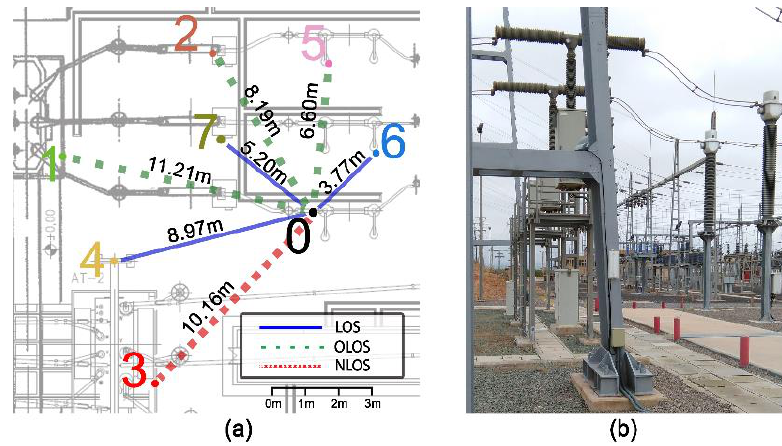
Figure 2. ( a ) Simulated base network ( b ) SG substation where the data was acquired.